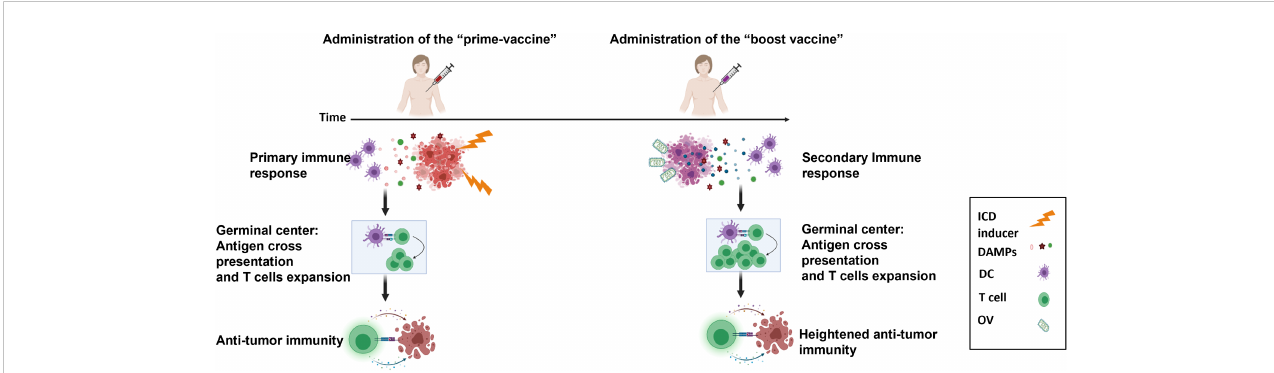
FIGURE 6 Model of heterologous prime-boost vaccination for TNBC. Adjuvant vaccination with a prime cellular vaccine results in the release of immunogenic cell death biomarkers (DAMPs, cytokines, chemokines) that recruit and activate antigen presenting cells to cross-present tumor associated antigens to tumor-targeted T cells. This is followed by the administration of a boost oncolytic virus-infected cellular vaccine to further focus the immune response on tumor antigens. An enhanced secondary immune response is instigated by this heterologous prime-boost vaccination to reduce metastatic and recurrent disease of